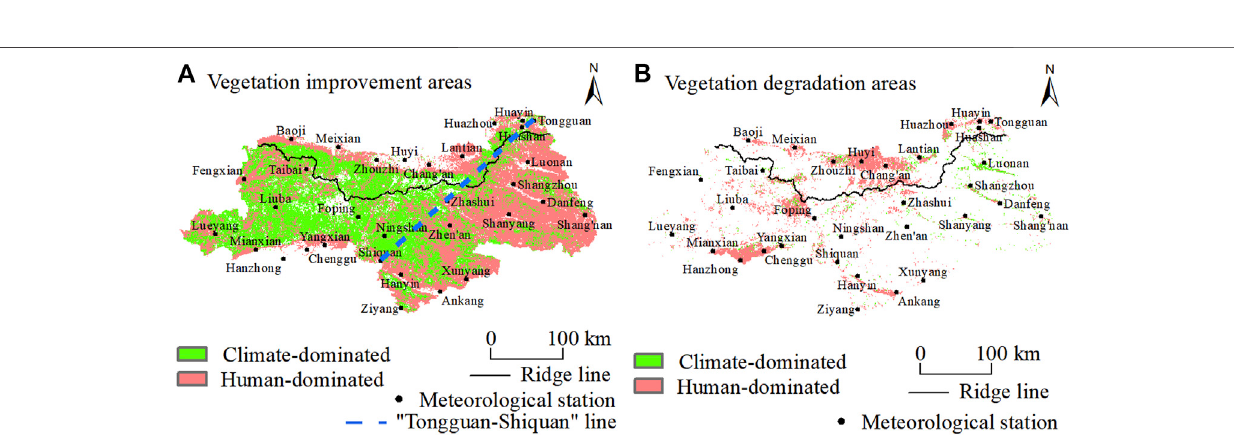
Frontiers in Earth Science |